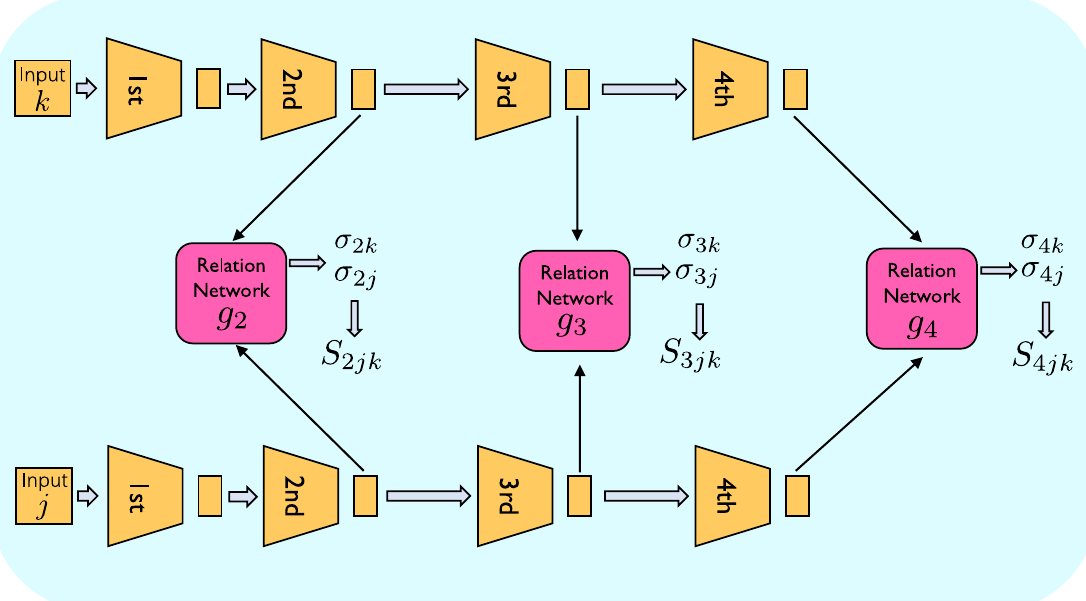
Figure 2. Computing the similarity between a pair of images, inputs j and k , based on the feature embeddings produced by the 2nd, 3rd, and 4th convolutional block (layer). The similarity values computed by the relation network modules are then used to construct multiple graphs for label